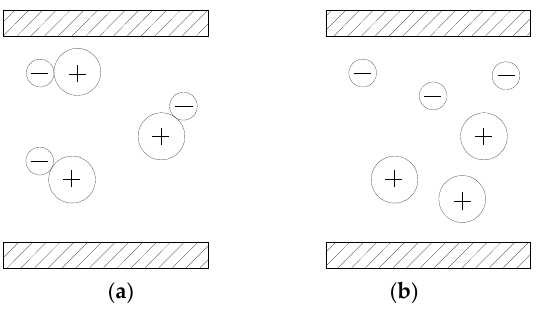
Figure 3. Ion dissociation under the influence of the field: ( a ) no ionization at low intensity fields; ( b ) ionization in the area of high intensity.